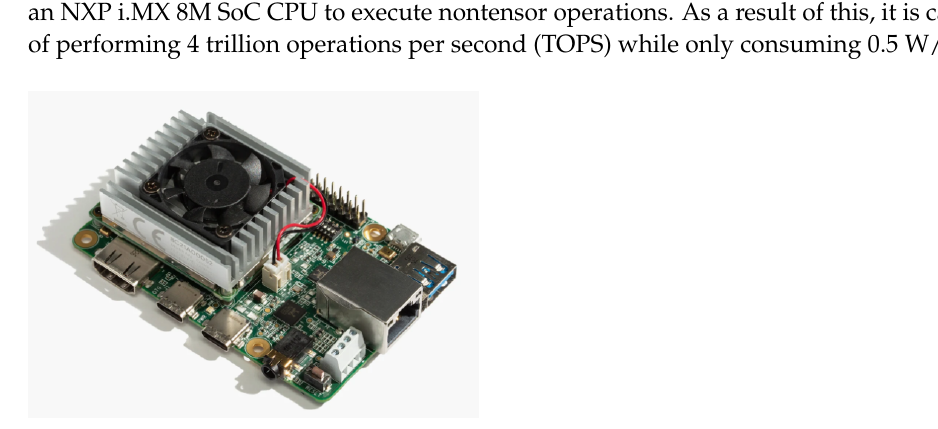
Figure 6. Google Coral TPU Development Board image from https://coral.ai/ (accessed on 31 May 2021)